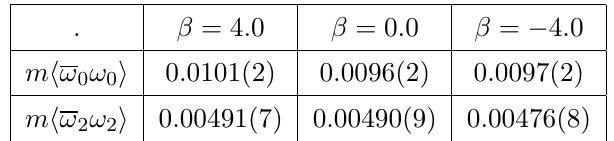
Table 1 . Condensates for several values of the measure coupling (cid:12) for S 2 using m = 0 : 001 and N 2 = 200, N 0 = 102.